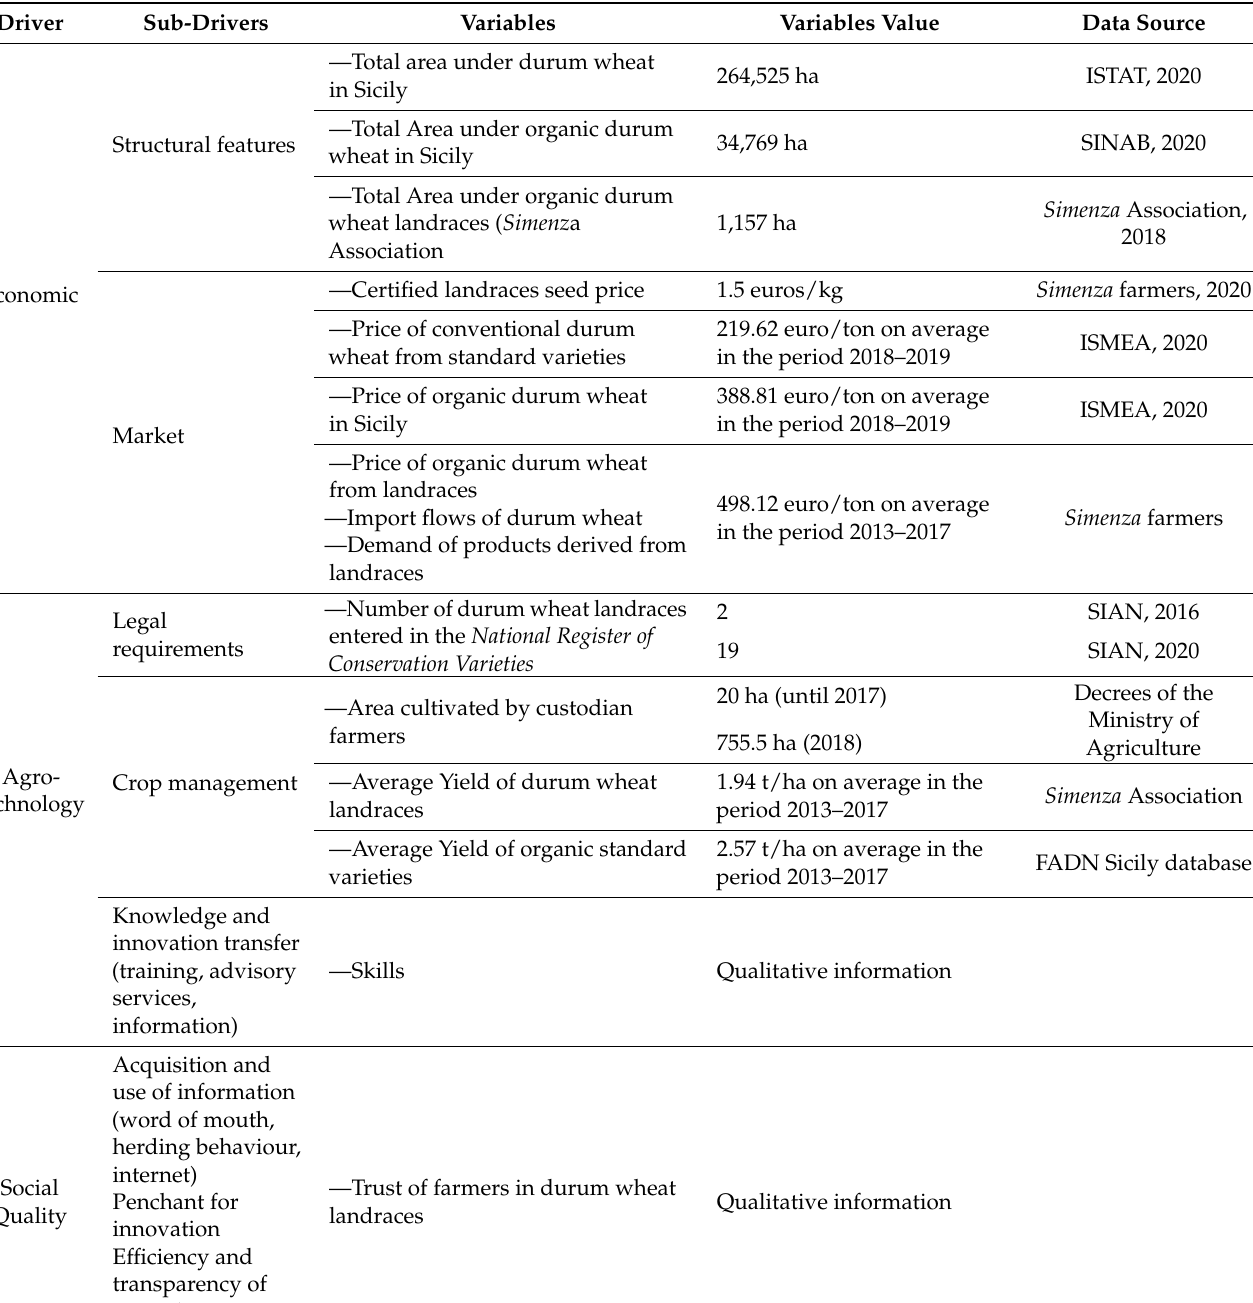
Table 3. Drivers influencing the regional landraces